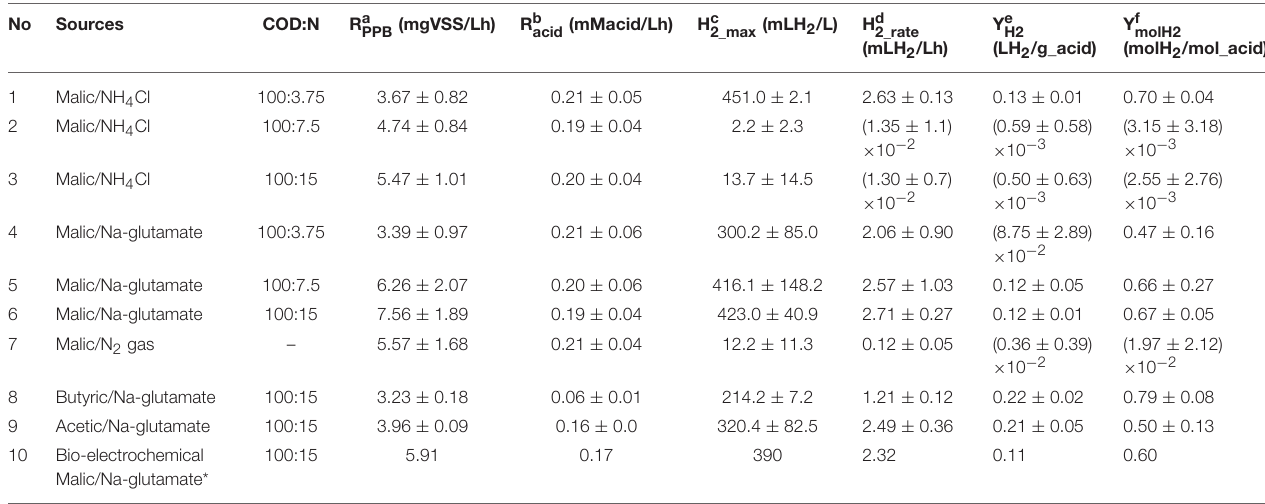
TABLE 2 | Comparison of H 2 production under different nitrogen and carbon